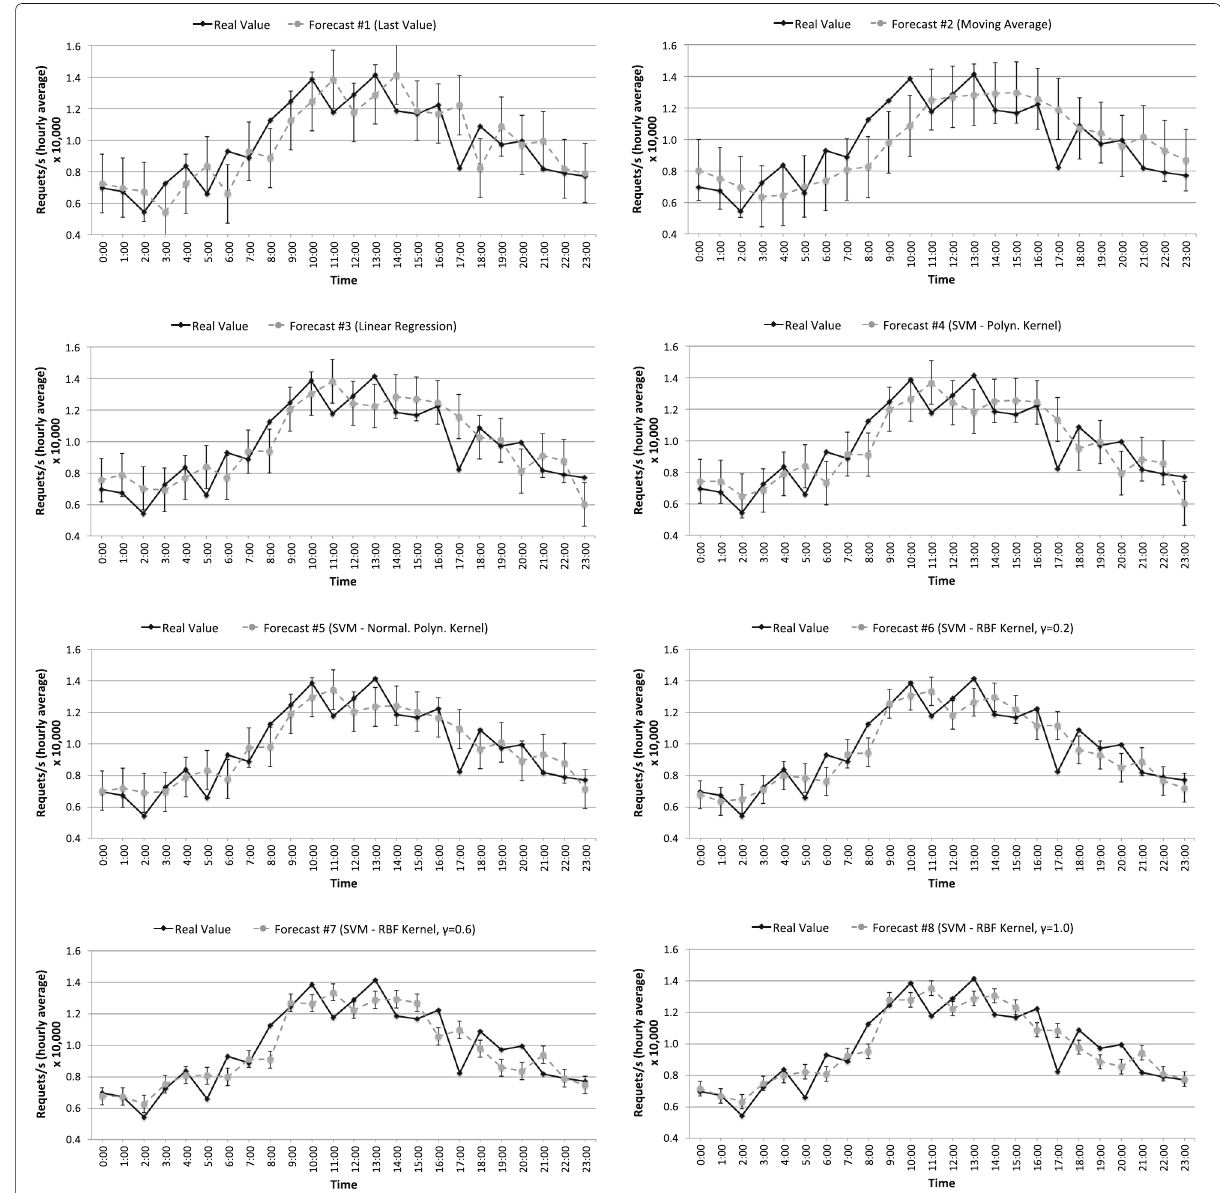
Fig. 5 Predicted server loads obtained with different forecasting models (#1 to #8). This figure shows the prediction results for the 24 h test interval using the various forecasting models (#1 to #8) compared to the real values of the average server load for the same hours. The bar errors of the different graphs represent the expected error (RMSE) of the model. This is computed as the error between the estimated data obtained by the forecasting model for the training period and the real training data of the time series